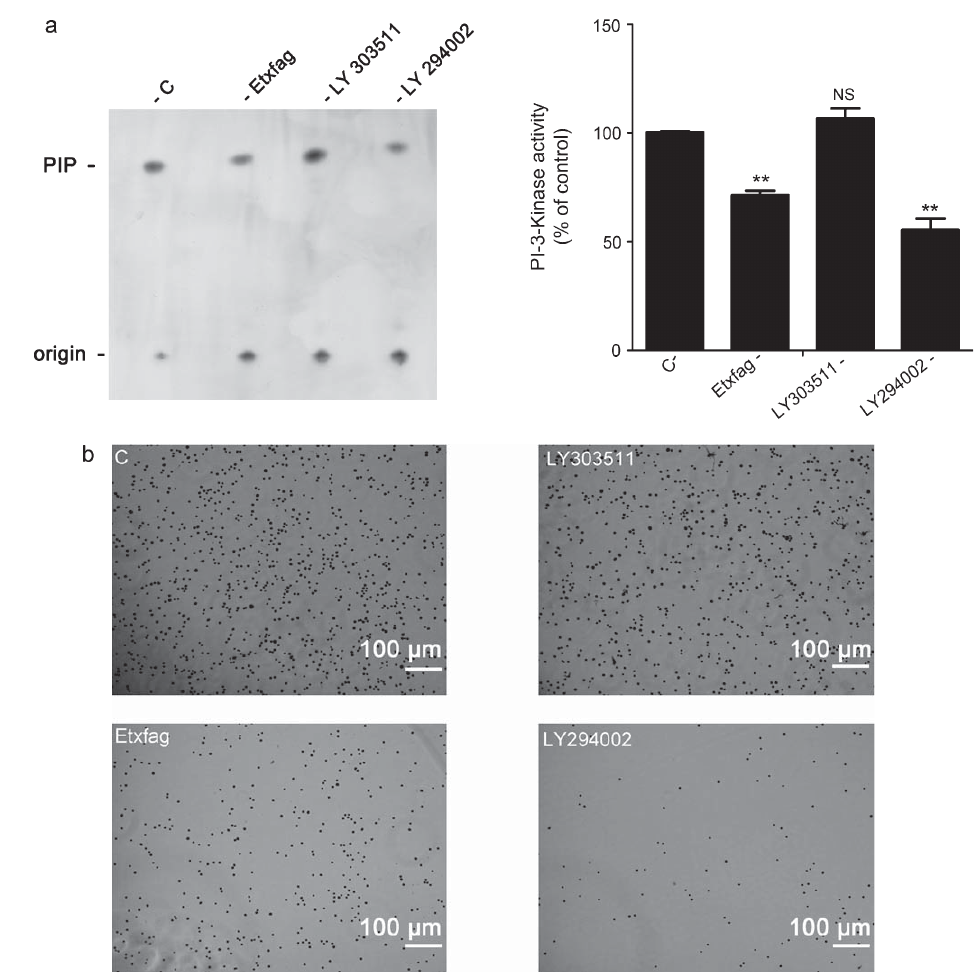
Fig. 7. Etxfag decreased PI-3 kinase activity in FN/V-adhered L1210 cells. a ) L1210 cells treated or not with 1 × 10 − 7 M etxfag for 24h were seeded to FN/V for 2h in a serum-free medium. Adherent cells were incubated with 25 (cid:3) M LY294002 or 25 (cid:3) M LY303511 for 30min before lysed. Anti-p85 immunoprecipitates were subjected to PI 3-kinase activity determined by PI phosphorylation in the presence of [ (cid:4) - 32 P] ATP. Phosphorylated PI (PIP) was separated by TLC and analysed by autoradiography. Quantification of PI phosphorylation was expressed as the percentage of signal obtained in FN/V-adhered cells. Results are representative of two independent experiments and values are the means ± SD. ** P <0.01 compared with control FN/V-adhered cells. NS=non significative. b ) L1210 cells treated or not with either 1 × 10 − 7 M etxfag for 24h or 25 (cid:3) M LY294002 or 25 (cid:3) M LY303511 for 30min were seeded to FN/V for 2h. Non-adherent cells were discarded and adherent cells stained by violet crystal were visualized by